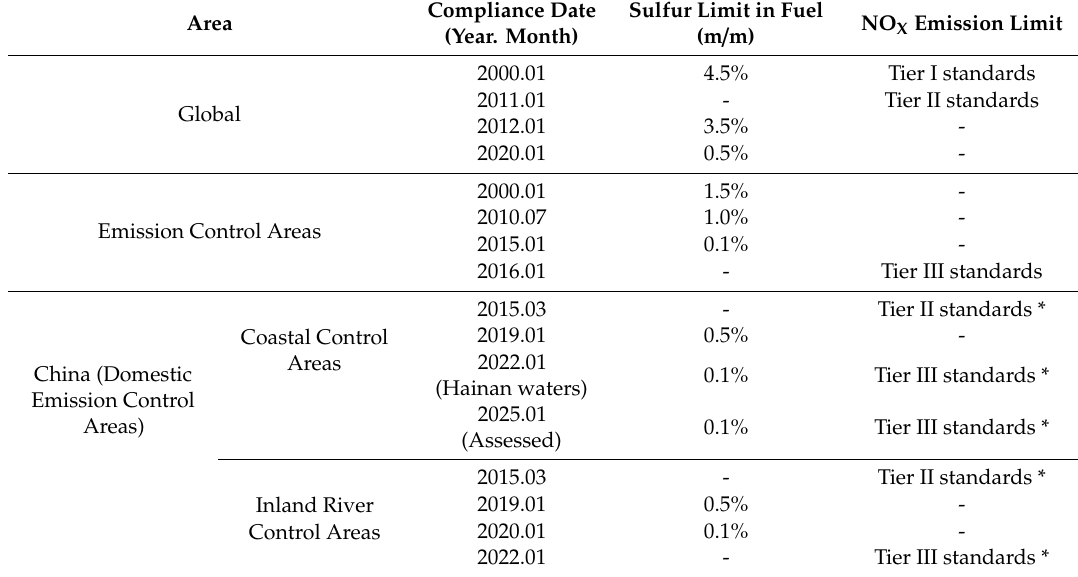
Table 2. The International Maritime Organization (IMO) and Chinese regulations related to sulfur limits in fuel and the NO X emission